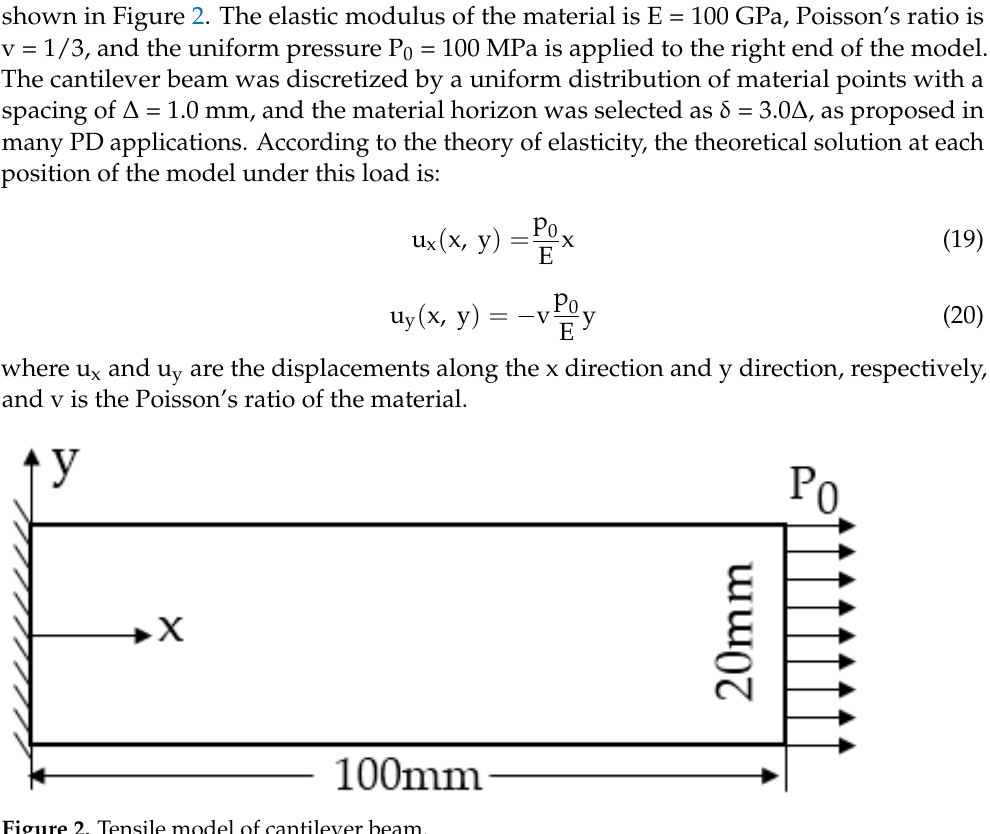
Figure 2. Tensile model of cantilever beam.